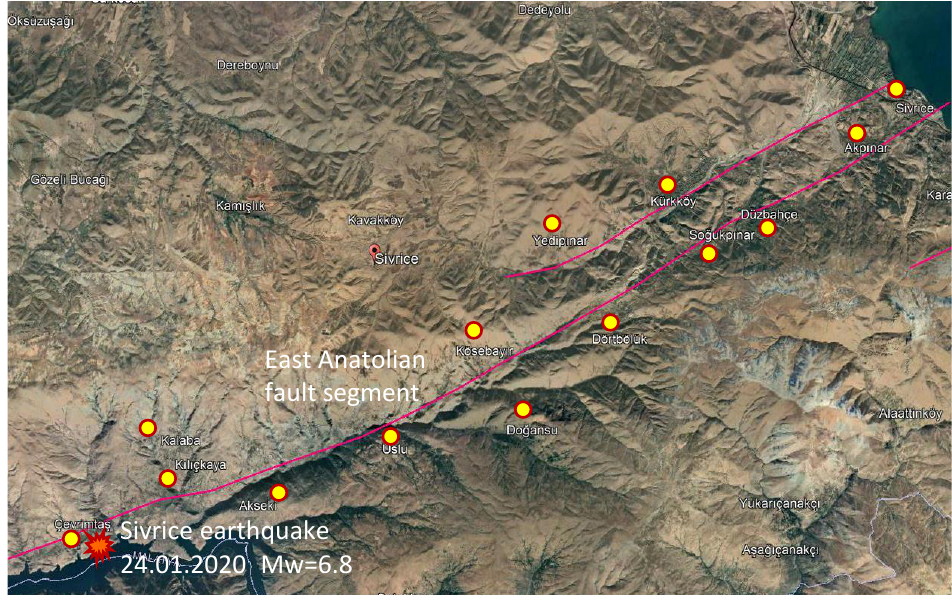
Figure 17. Remote villages with tens of non-engineered URM buildings in eastern Anatolia, Turkey. The line shown on the map is a seismically active segment of the East Anatolian Fault (EAF), on which the latest major earthquake occurred in January 2020 with Mw = 6.8, as shown in the figure. This earthquake caused severe damage in most of the remote villages, and it was very difficult to access them due to harsh climatic conditions in the mountainous regions.